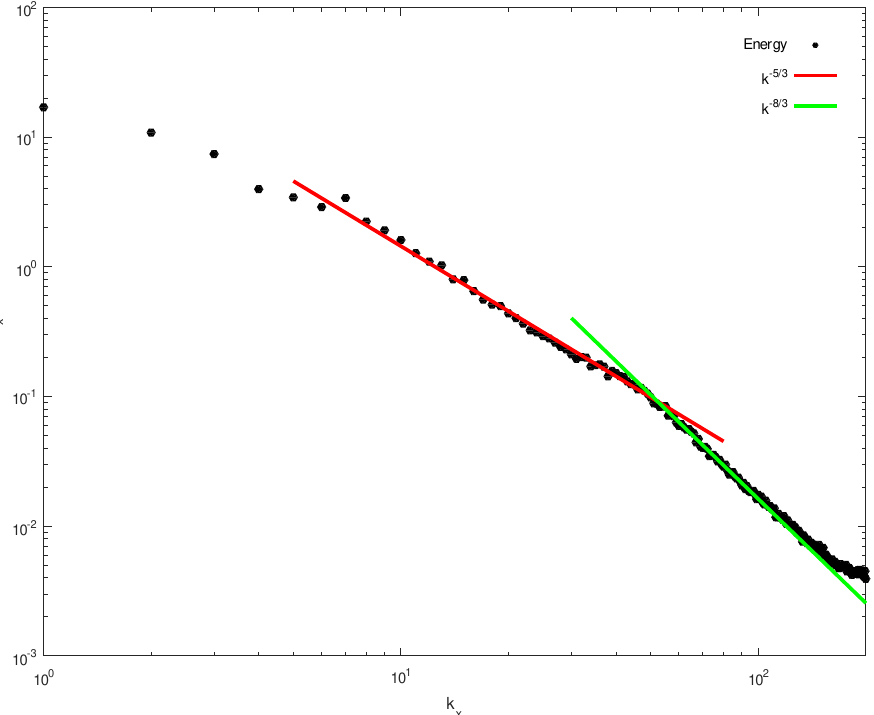
Figure 3. Time-averaged kinetic energy spectrum of the inertial flow. The straight lines, correspond- ing to k − 5/3 and k − 8/3 slopes, are provided for